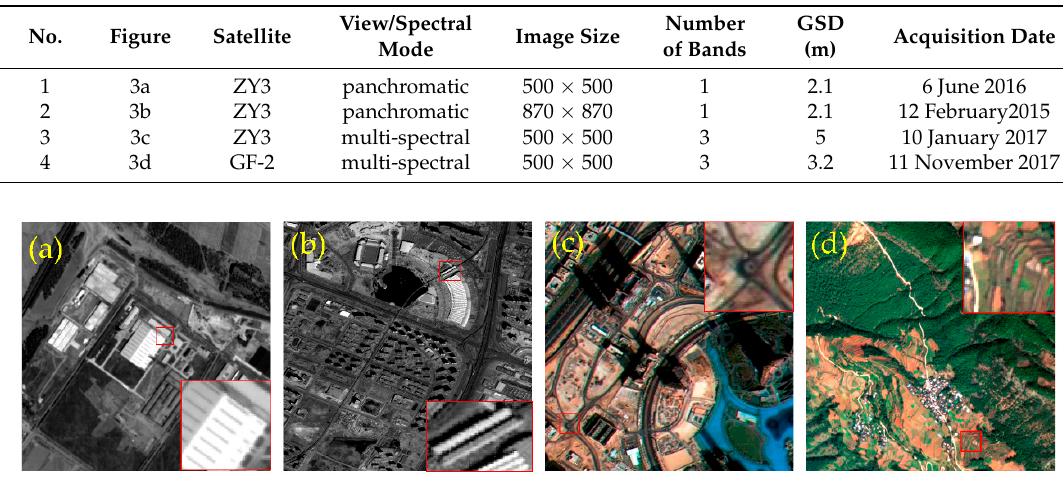
Figure 3. Original high-resolution (HR) remote sensing images ( a ) ZY-3 panchromatic image; ( b ) ZY-3 panchromatic image; ( c ) ZY-3 multi-spectral image; ( d ) GF-2 multi-spectral image.